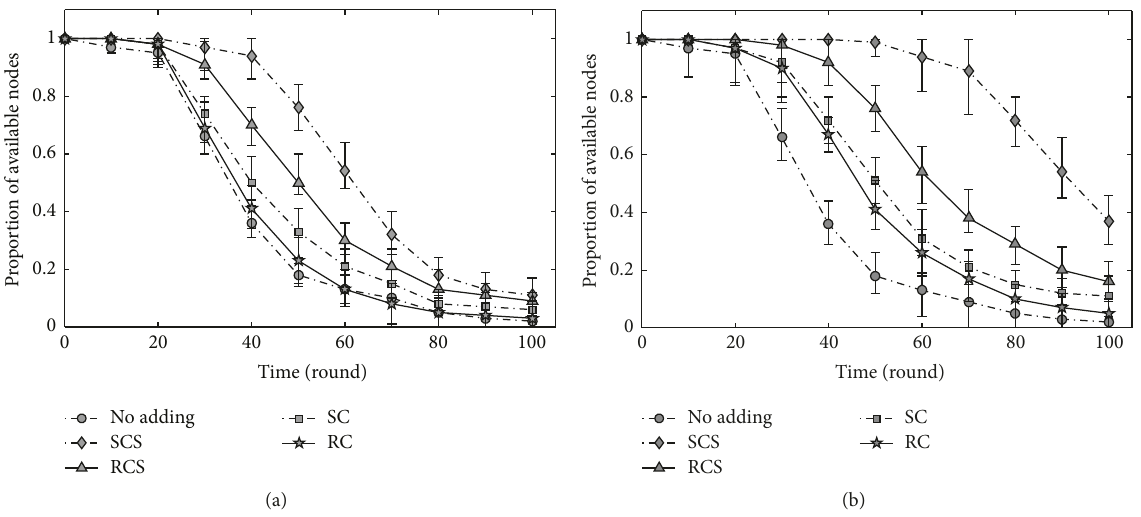
Figure 7: Energy consumption of the network with 𝑞 = 0.01 and 𝑞 = 0.1 . (a) 𝑞 = 0.01 . (b) 𝑞 = 0.1